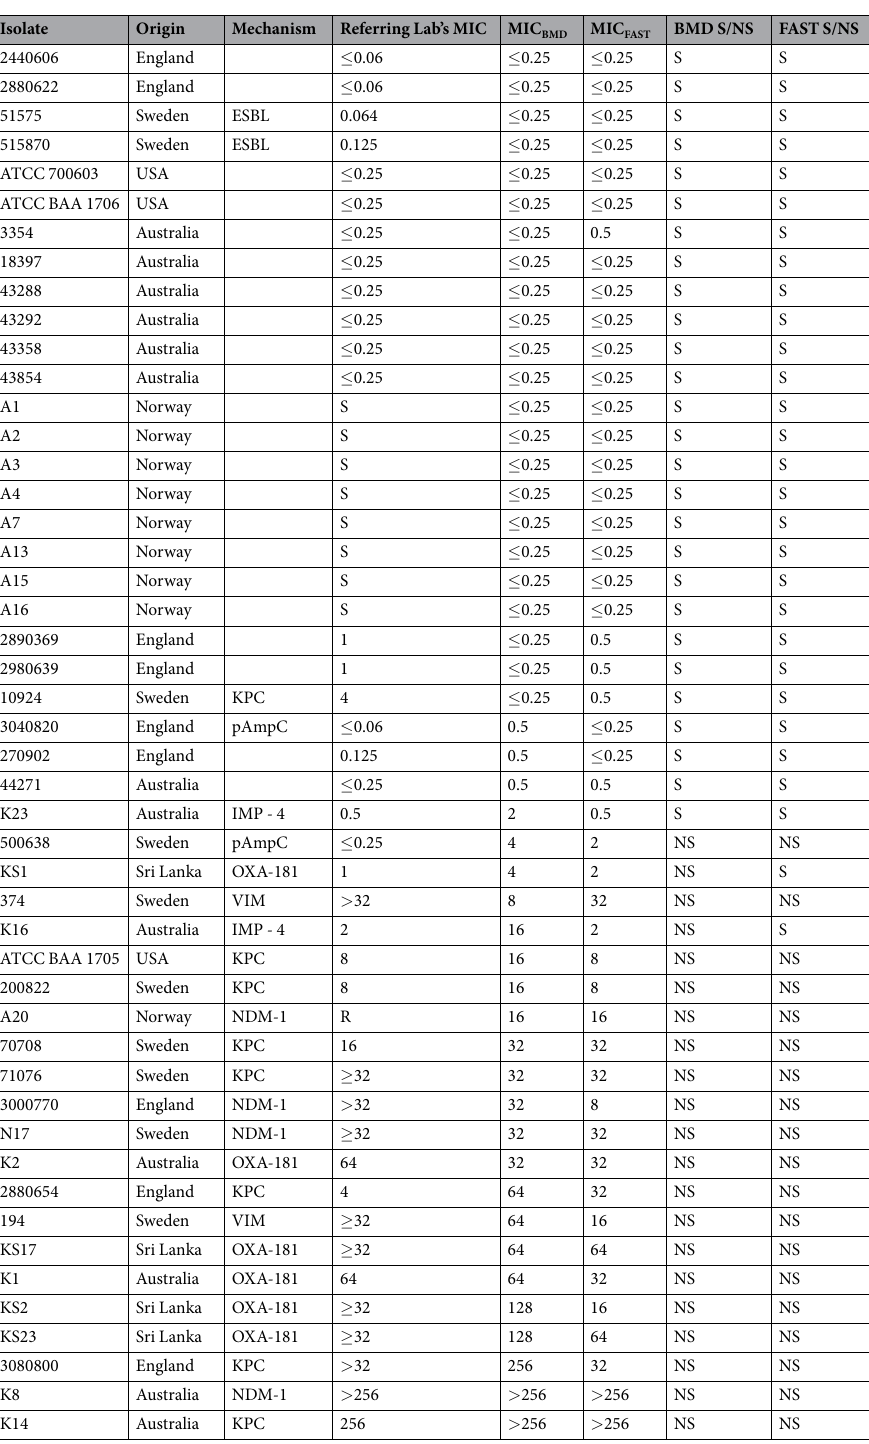
Table 2. Meropenem susceptibilities (mg/L) for 48 Klebsiella isolates from diverse locations and with diverse resistance mechanisms. MIC FAST : FAST method MIC. MIC BMD : broth microdilution MIC. S: Susceptible to meropenem, MIC ≤ 2 mg/L. NS: Non-susceptible to meropenem, MIC > 2 mg/L. 48 isolates were exposed to therapeutic grade meropenem and subjected to FAST in technical triplicate, with the MIC FAST and MIC BMD values reported as the mode of replicates. Interpretation was according to EUCAST criteria: (S = MIC ≤ 2 mg/L; NS = MIC > 2